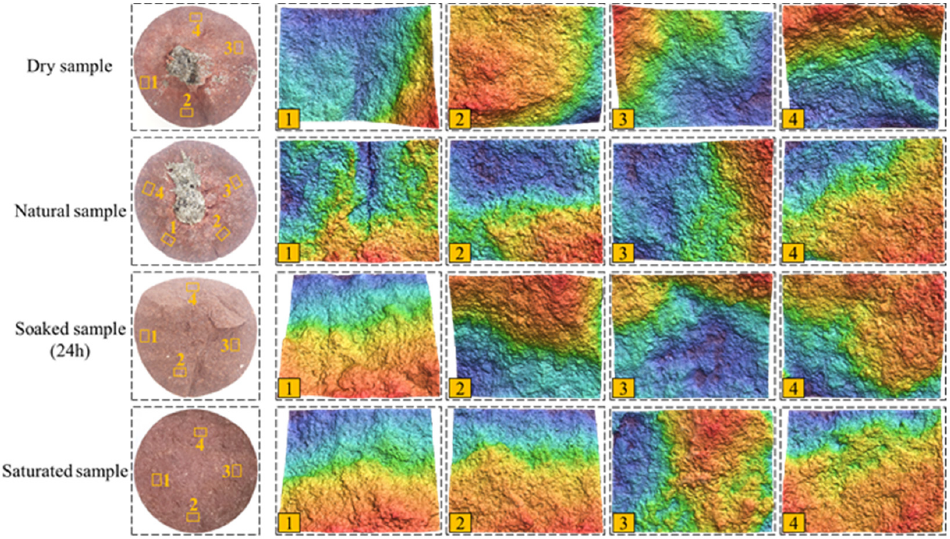
Figure 5. Three-dimensional scanning images of local area of fracture surface.